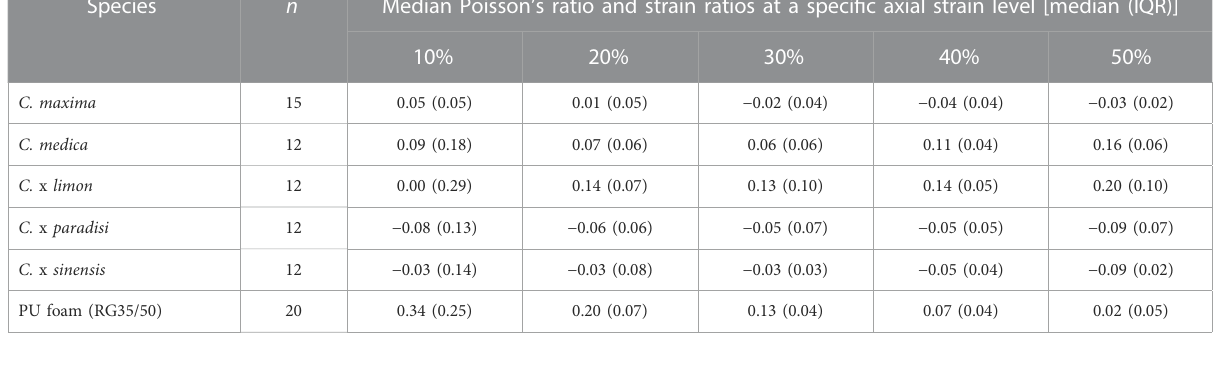
TABLE 5 Poisson ’ s ratio (at 10% axial strain) and strain ratios (for > 10% axial strain) at different strain levels for all tested citrus species: pomelo ( C. maxima ), citron ( C. medica ), lemon ( C. x limon ), grapefruit ( C. x paradisi ), orange ( C. x sinensis ), and for PU foam (RG35/50). Species